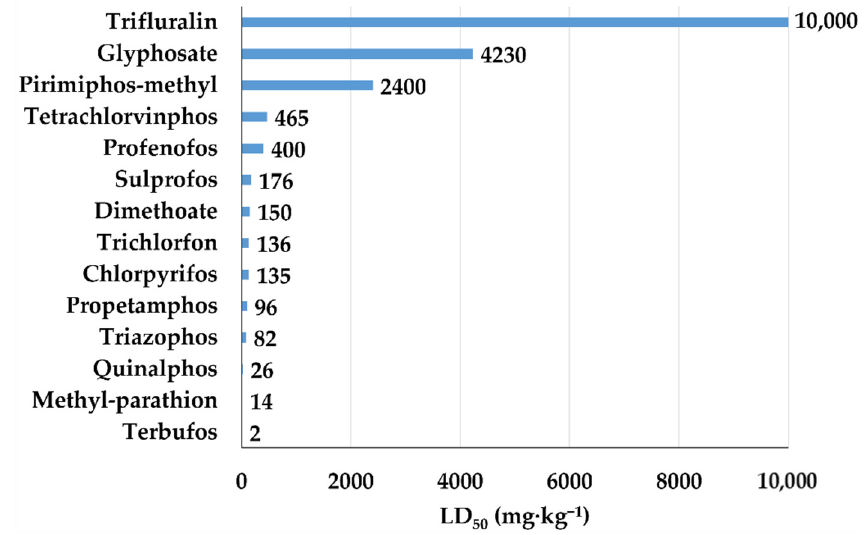
Figure 6. LD 50 (mg·kg − 1 ) of organophosphates for rat.